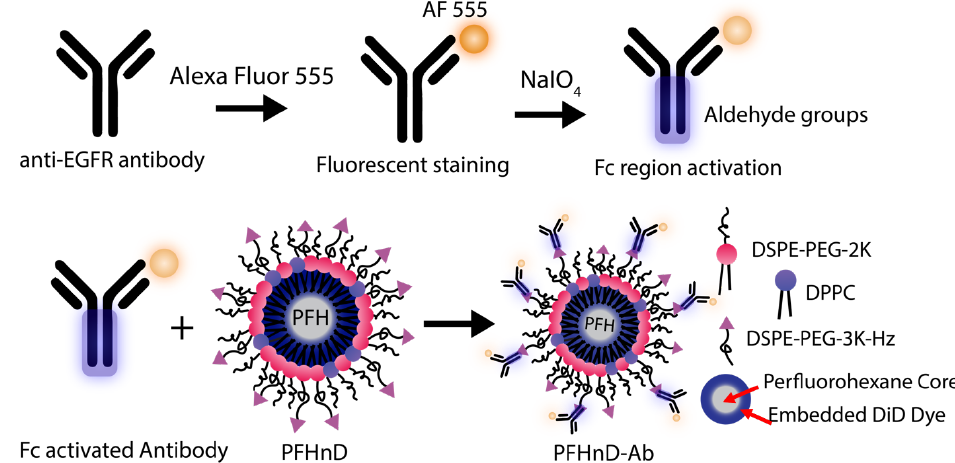
Figure 1. The antibodies were first labeled with AF 555 antibody labeling kit. Second, the Fc region of the antibody was oxidized by reacting with 100-mM NaIO 4 leading to aldehydes on the Fc region. The aldehydes on the activated Fc region then bind to the hydrazides available on the surface of the PFHnDs, forming a stable hydrazone bond and leading to the final antibody conjugated nanodroplet (PFHnD-Ab). The core of the PFHnD contains perfluorohexane (b.p. 56 °C) and DiD fluorescent